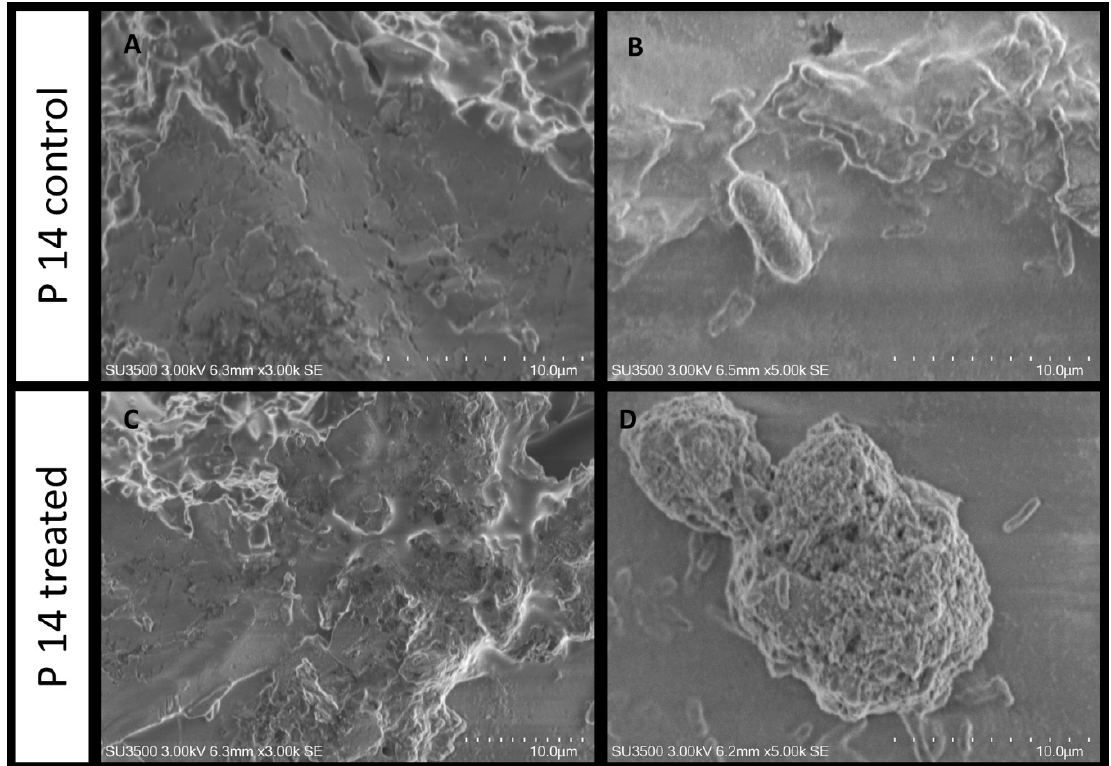
Figure 6. SEM analysis. P. aeruginosa PA14 untreated ( A , B ) and treated ( C , D ) with SN_TAE2020. SEM ( A ) 3000 × , biofilm appears as a dense and smooth-surfaced mass; ( B ) 5000 × , a bacterial cell is adherent to the matrix surface; ( C ) 3000 × , the treatment affects the biofilm surface, and deep holes are seen partially perforating its surface; ( D ) 5000 × , a globular mass of biofilm with a spongy aspect is shown, where bacterial cells are dispersed on its surface or lay detached and sparsely on the surroundings.